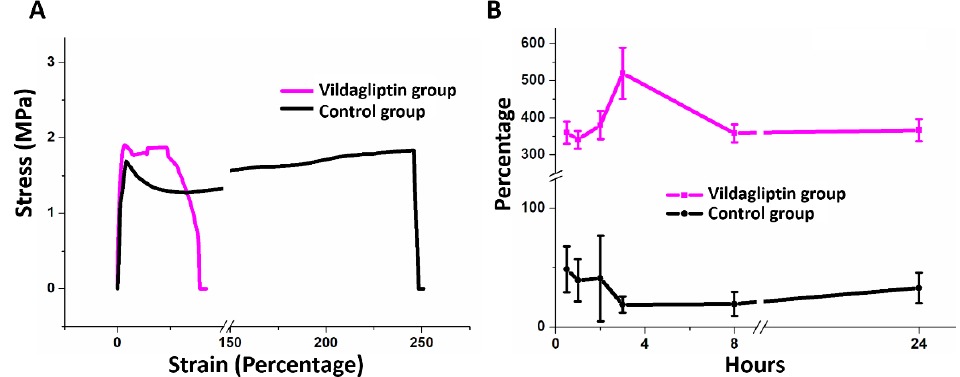
Figure 2. Stress – strain curves of nanofibrous membranes of the vildagliptin and control (drug-free) groups ( A ). Black corresponds to drug-free PLGA and red corresponds to vildagliptin/PLGA nanofibrous membranes. Variation in the water-retention capacity of nanofibers for 24 h ( B ).